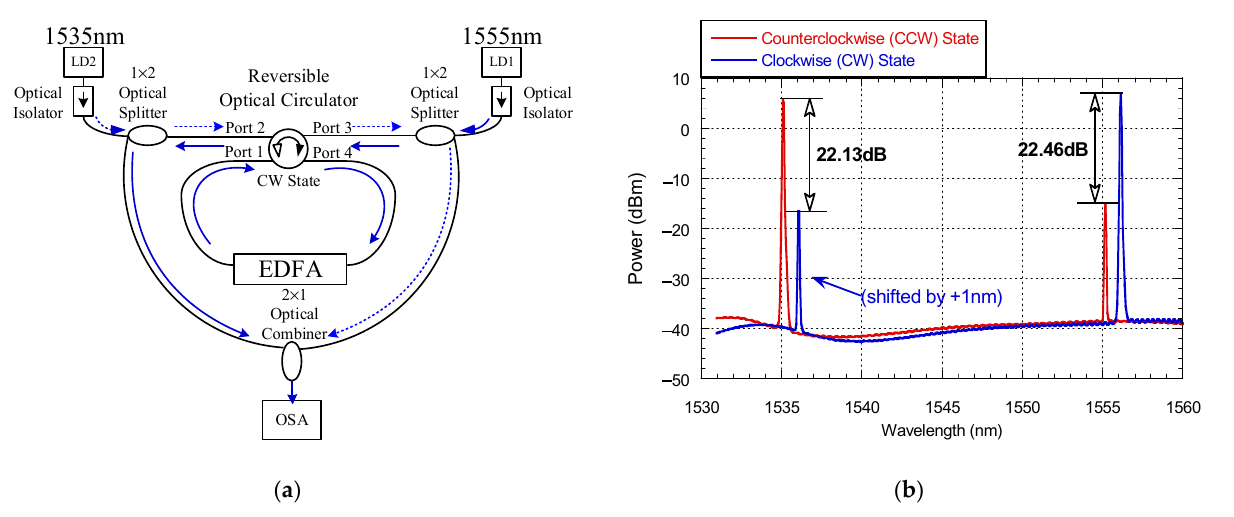
Figure 7. Dynamic function test of the four-port reversible optical circulator: ( a ) setup ( OSA: optical spectrum analyzer, Anritsu MS9710C) and ( b ) results.